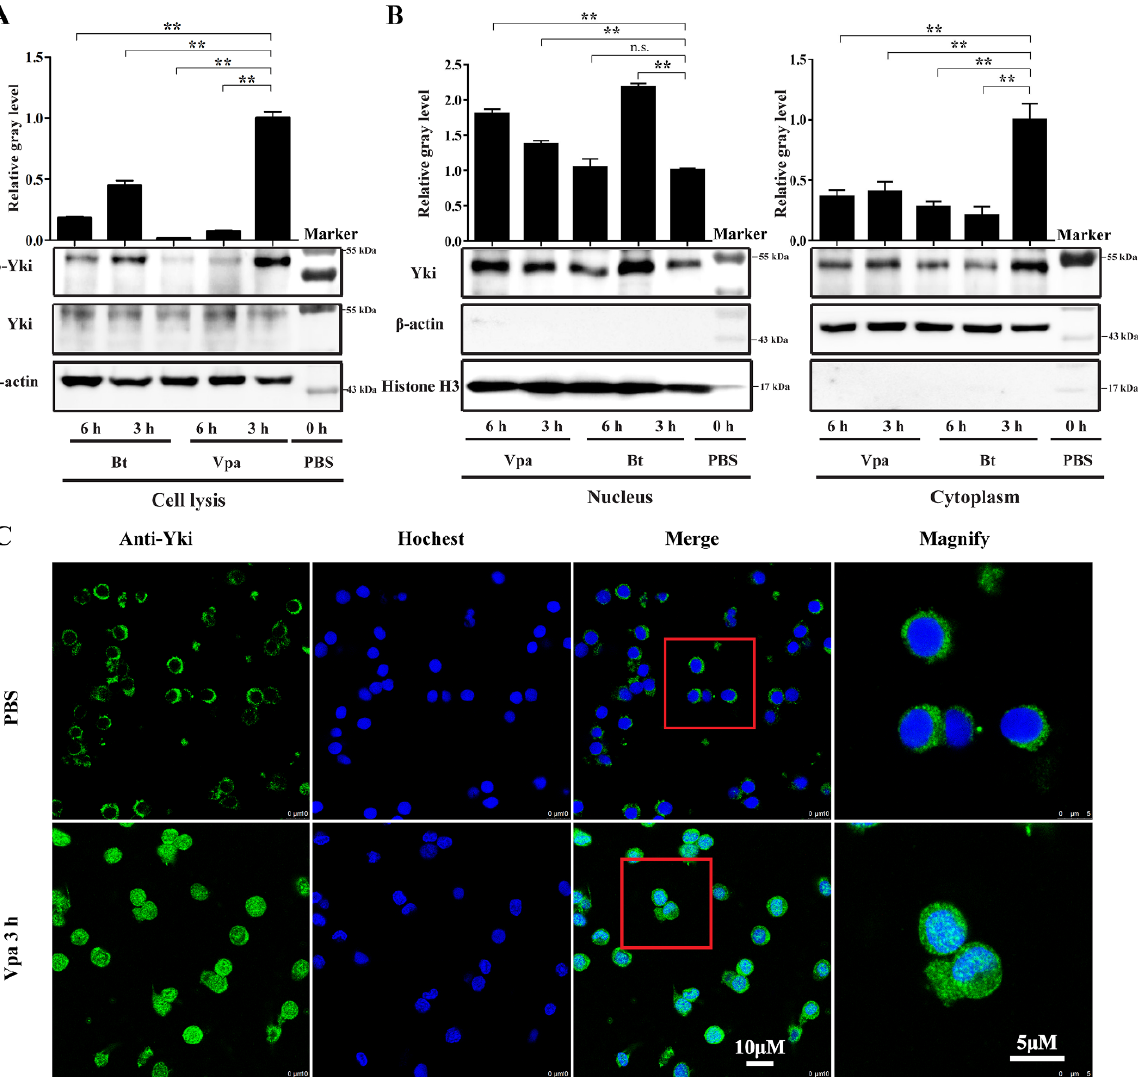
Figure 2. Activation of Yki after bacterial infection. ( A ) Western blot analysis of phosphorylated and unphosphorylated Yki in hemocytes from shrimp infected with V. parahaemolyticus (Vpa) and B. thuringiensis (Bt). The gray values of Yki bands were normalized to those of β -actin. ( B ) Western blot analysis of Yki protein distribution in the nucleus and cytoplasm of hemocytes from bacteria-infected shrimp. The gray values of Yki bands in the nucleus and cytoplasm were normalized to those of histone H3 and β -actin, respectively. **, p < 0.01 and n.s., p > 0.05 by two-tailed unpaired Student’s t -test. ( C ) Immunofluorescence analysis of the expression of Yki in hemocytes at 3 h post V. parahaemolyticus or PBS-mock infection.